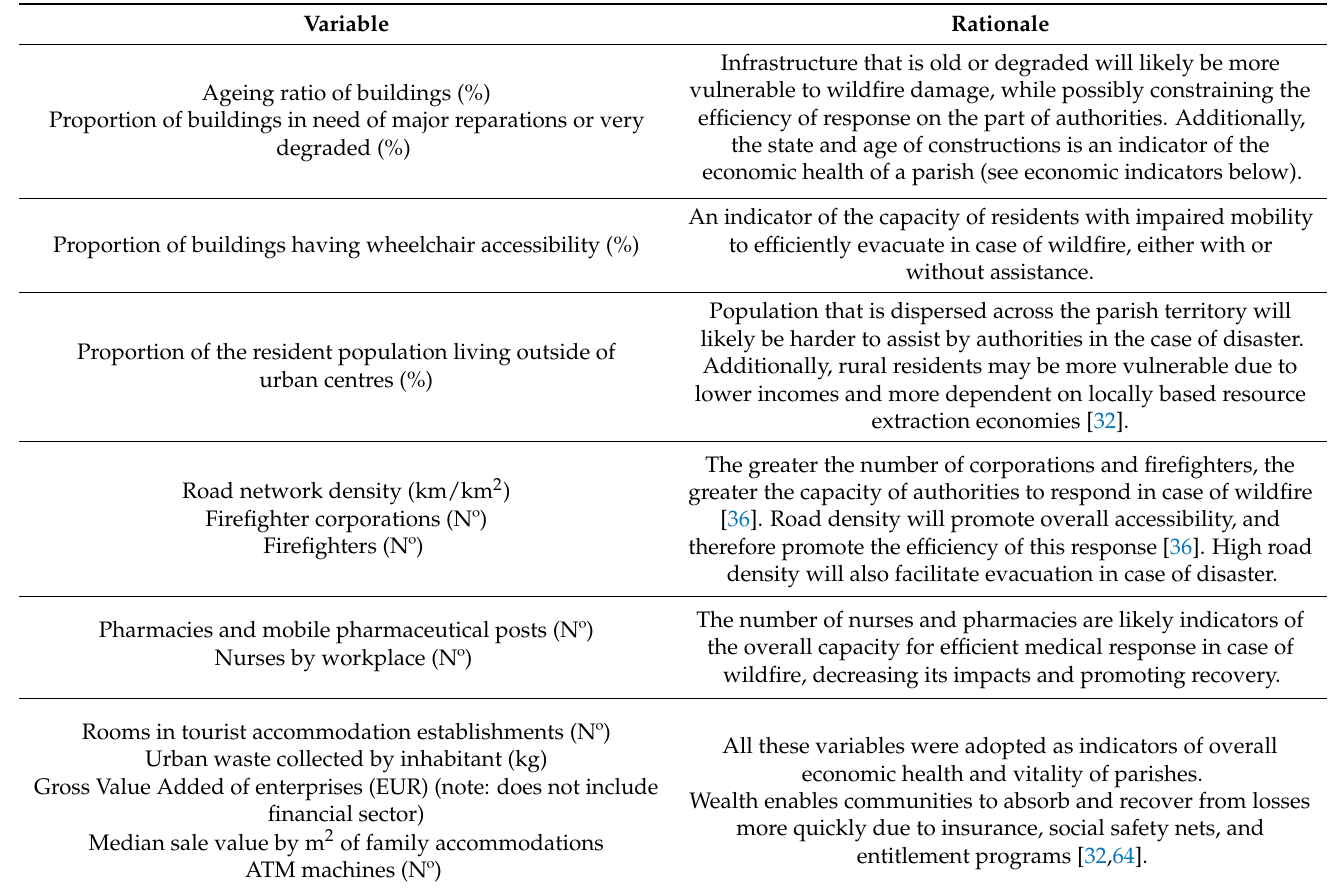
Table A2. Conceptual justification for the variables adopted for expressing support